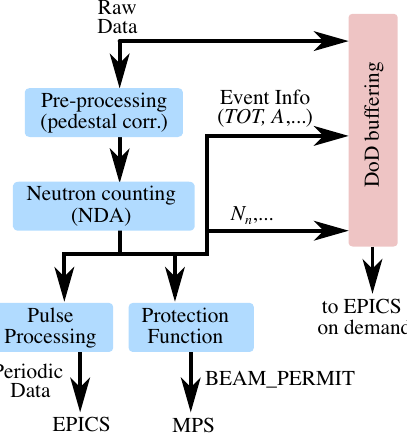
FIG. 4. Simplified block diagram of the data processing chain for one nBLM detector. DoD refers to the data that can only be retrieved on demand, for explanation see text at the end of Sec.